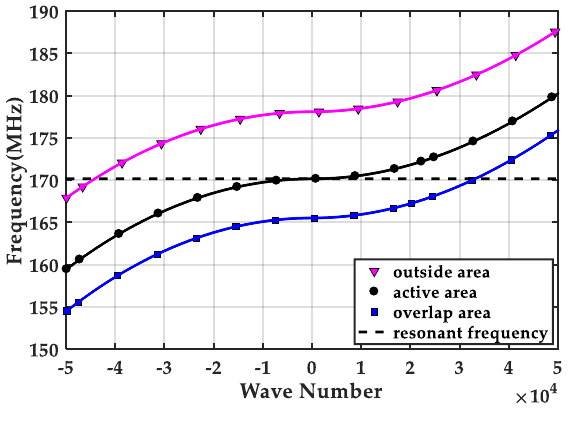
Figure 6. Schematic of the dispersion curve of the thickness extensional (TE) wave modes in the active, overlap, and outside areas.